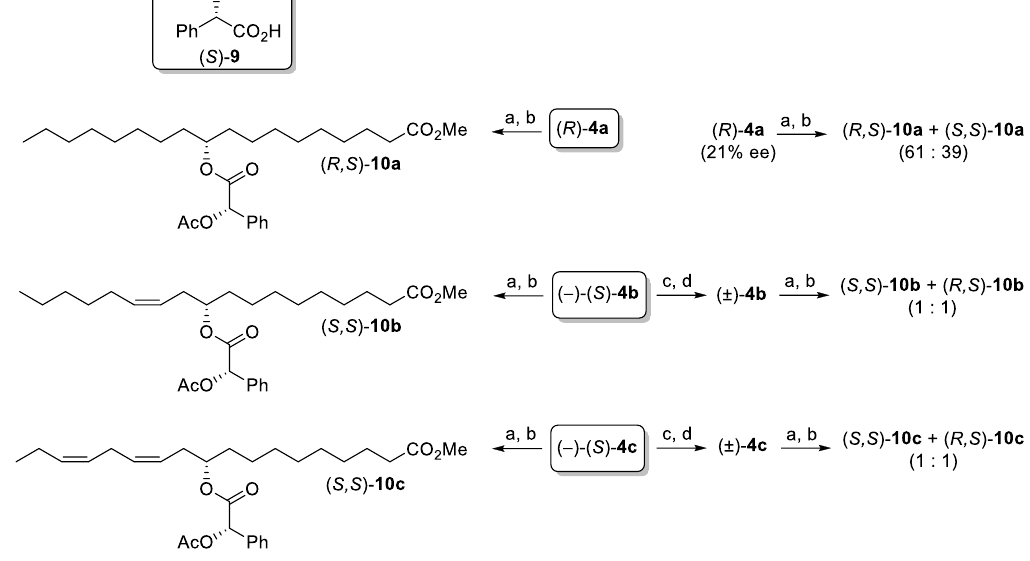
Figure 5. Synthesis of racemic (12 Z )-10-hydroxy-octadecenoic and (12 Z ,15 Z )-10-hydroxy-octadecadienoic acids and the transformation of the HFAs 4a – c into the corresponding ( S )- O -acetylmandelate esters 10a – c . Reagents and conditions: (a) CH 2 N 2 , Et 2 O, 0 °C; (b) ( S )- 9 , DCC, cat. DMAP, CH 2 Cl 2 r.t.; (c) DMSO, ClCOOCl, Et 3 N, CH 2 Cl 2 , −70 °C; (d) NaBH 4 , MeOH, 0 °C.